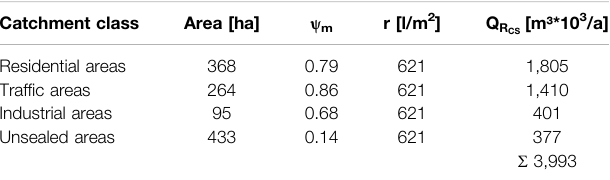
TABLE 1 | Runoff of the annual precipitation of the combined sewerage catchment area. Runoff coef fi cients ( ψ m ), annual rainfall (r), and rainfall runoff ( Q ) R CS